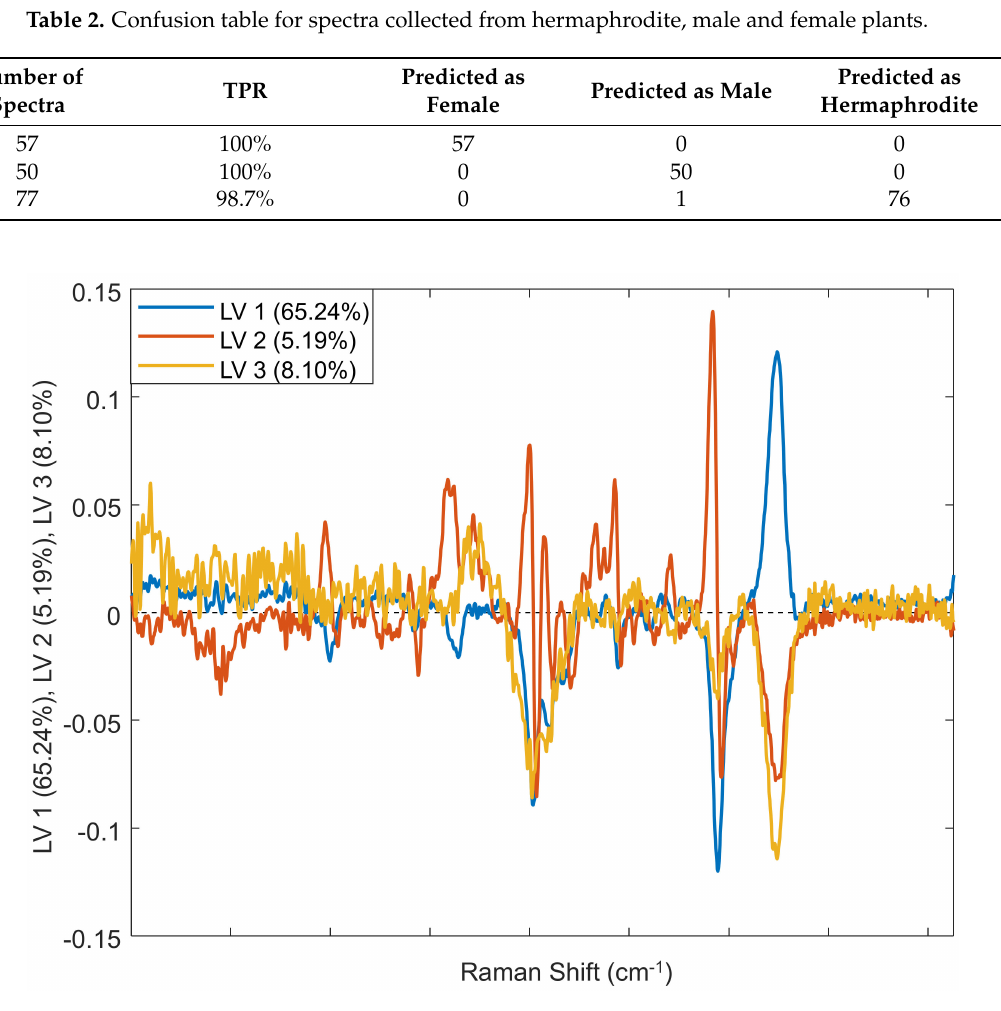
Figure 3. Loading plot of the three predictive components (PC) in the Raman spectra of male, female, and hermaphrodite cannabis plants. See Table 1 for a description of the biological origin of the